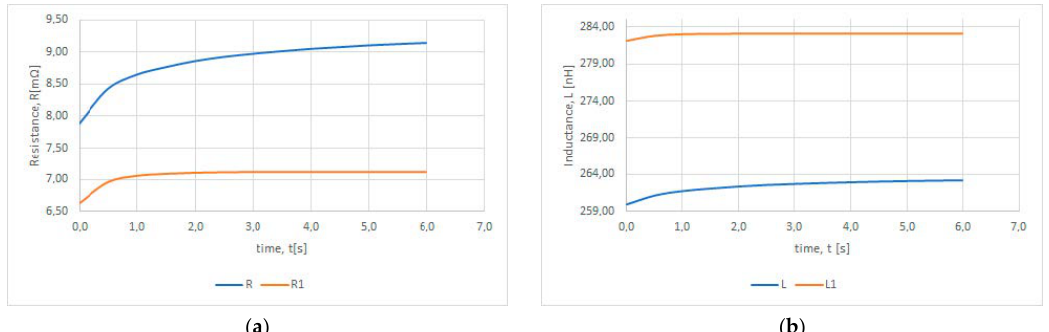
Figure 13. Resistance ( a ) and inductance ( b ) of the system with (blue lines) and without (red lines) a workpiece as a function of time.